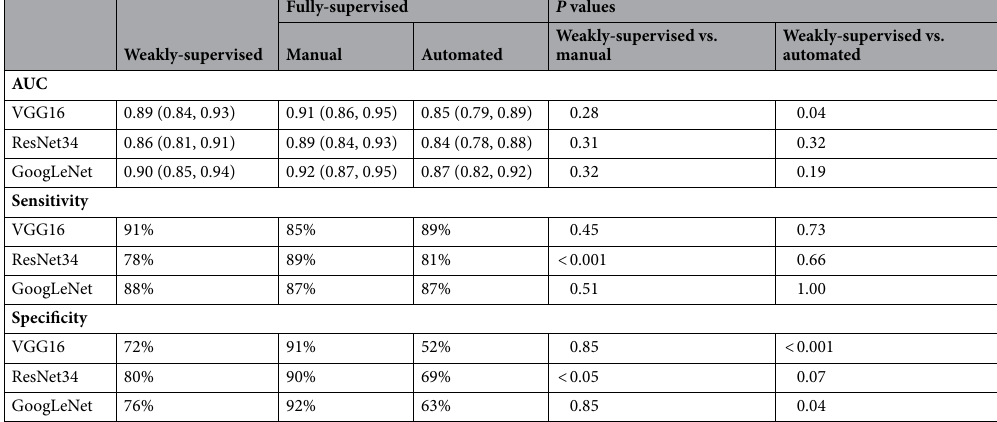
Table 3. Diagnostic performance metrics of weakly-supervised and fully-supervised deep learning algorithms in external validation set. 95% confidence intervals in parenthesis.